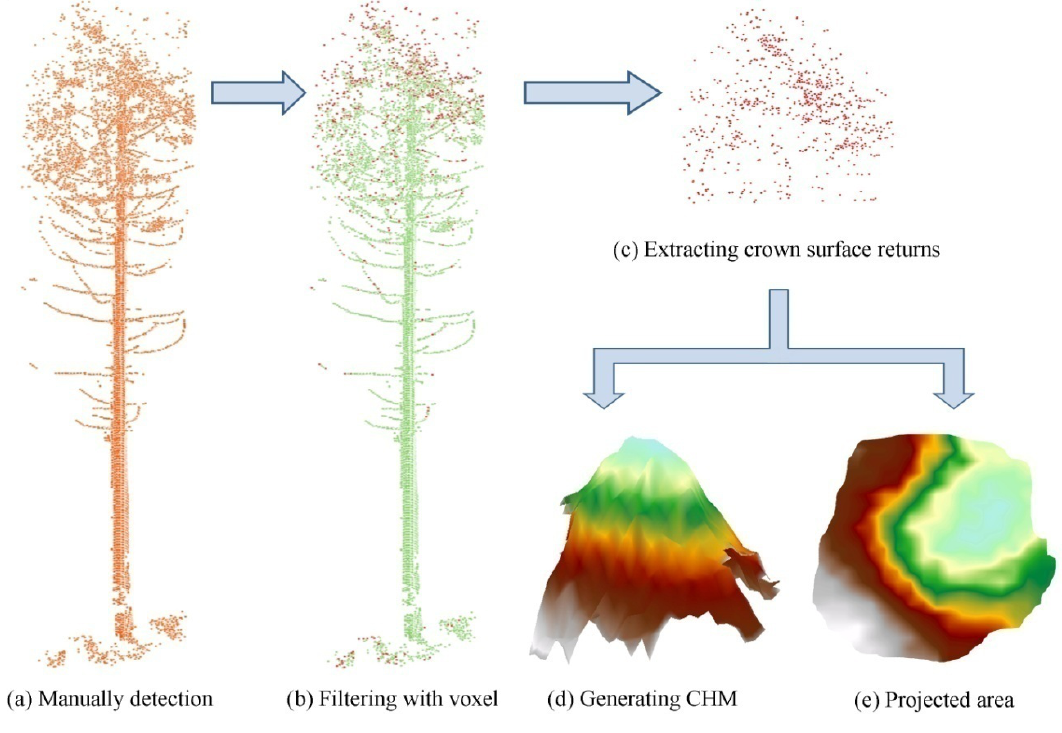
Figure 5. Manually detected individual trees using the TLS data (a) , filtered TLS data with moving voxel (b) , crown surface returns among the filtered TLS data (c) , crown height model (CHM) generated from the crown surface returns (d) , and projected shape of CHM (e)